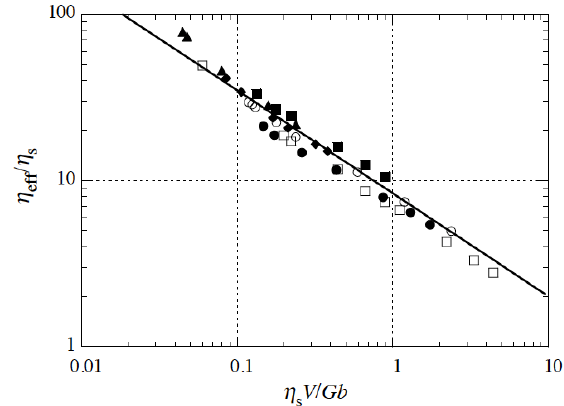
Figure 9. Relation between the reduced effective viscosity ( 𝜂 𝑒𝑓𝑓 /𝜂 𝑠 ) of the near-surface region of the hydrogel as a function of the Weissenberg number ( 𝑊 𝑒 = 𝜏 𝑅 𝑉/ξ = 𝜂 𝑠 𝑉/𝐺𝑏 ) for hydrogels of different compositions [55]. 𝐺 is the shear modulus of the hydrogel and 𝑏 is the monomer size. Reprinted with permission from Springer Nature Customer Service Centre GmbH: The European Physical Journal E, Self-healing slip pulses and the friction of gelatin gels, Baumberger, T., C. Caroli, and O. Ronsin Copyright (2003).